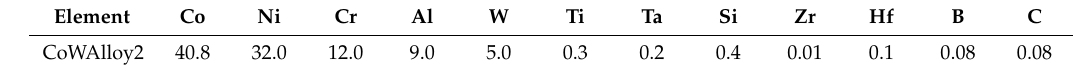
Table 1. Nominal alloy composition of CoWAlloy2 in at.%.